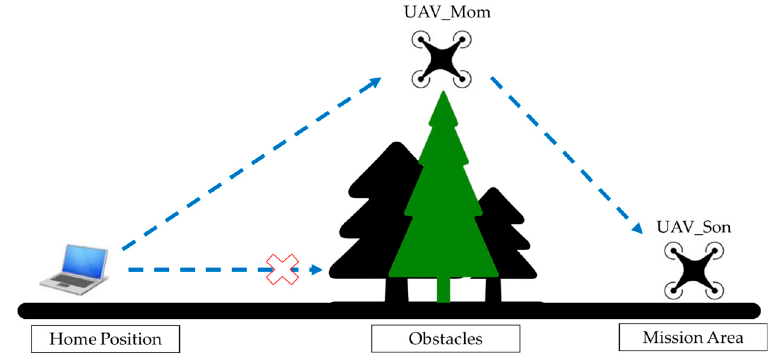
Figure 17. Schematic of cross-obstacle communication relay flight test.